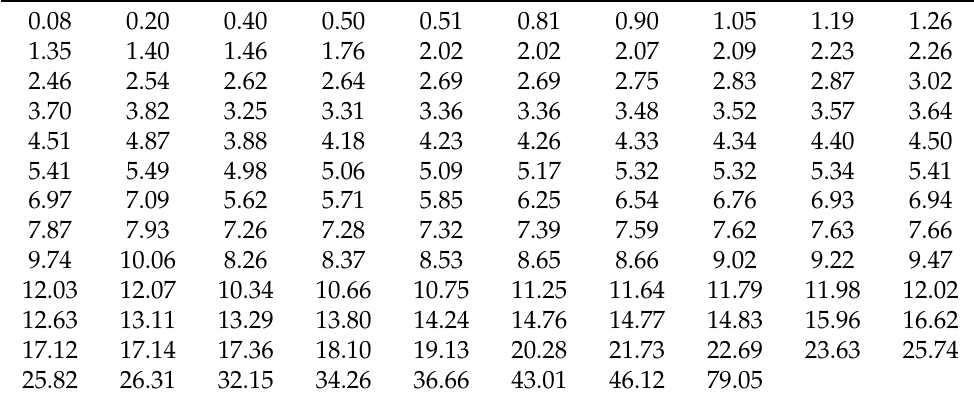
Table A5. The remission times (in months) from 128 bladder cancer patients.